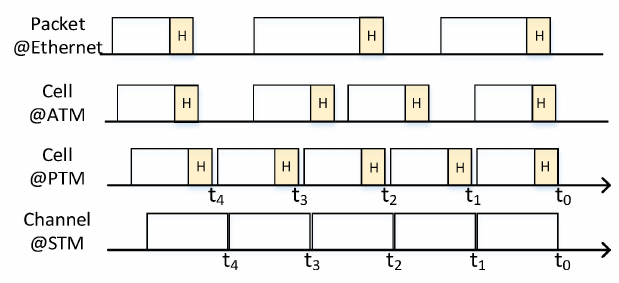
Figure 6. Transmitting of